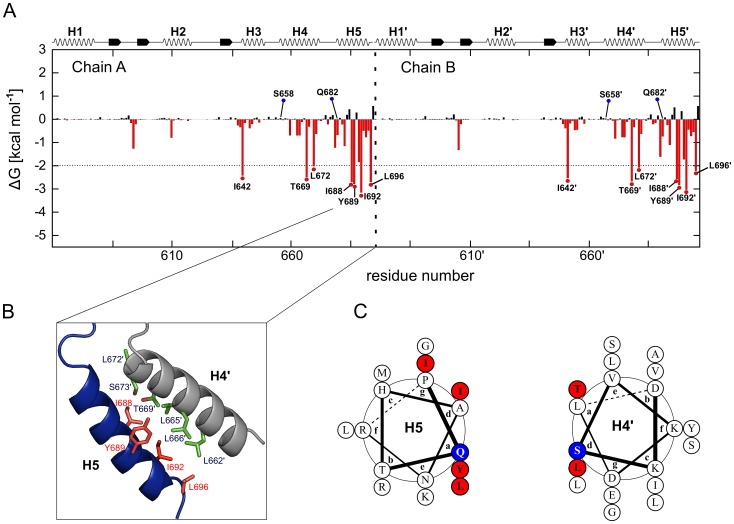
Hot spot and cold spot prediction.(A) Contribution to the dimer stabilization of each amino acid within the hHsp90 CTD. ΔG values are calculated by the MM-GB/SA approach [37], [83] starting from the homology model, employing a structural decomposition of the effective energy [10]. The standard error in the mean is <0.1 kcal mol−1 in all cases. Amino acids contributing to the dimerization with ΔG<−2 kcal mol−1 are considered hot spots and are indicated in the graphic by red dots. In addition two “cold spots” mentioned in the text are marked with blue dots. In the upper part of the panel, the secondary structure of the CTD is shown. The amino acids are numbered according to the full length hHsp90 α isoform (UniProt code: P07900). (B) Hot spot residues localized on H5 (red) and interacting residues on H4′ (green). (C) Helical wheel representation showing the position of hot spots (red) and cold spots (blue) on helices H5 and H4′.